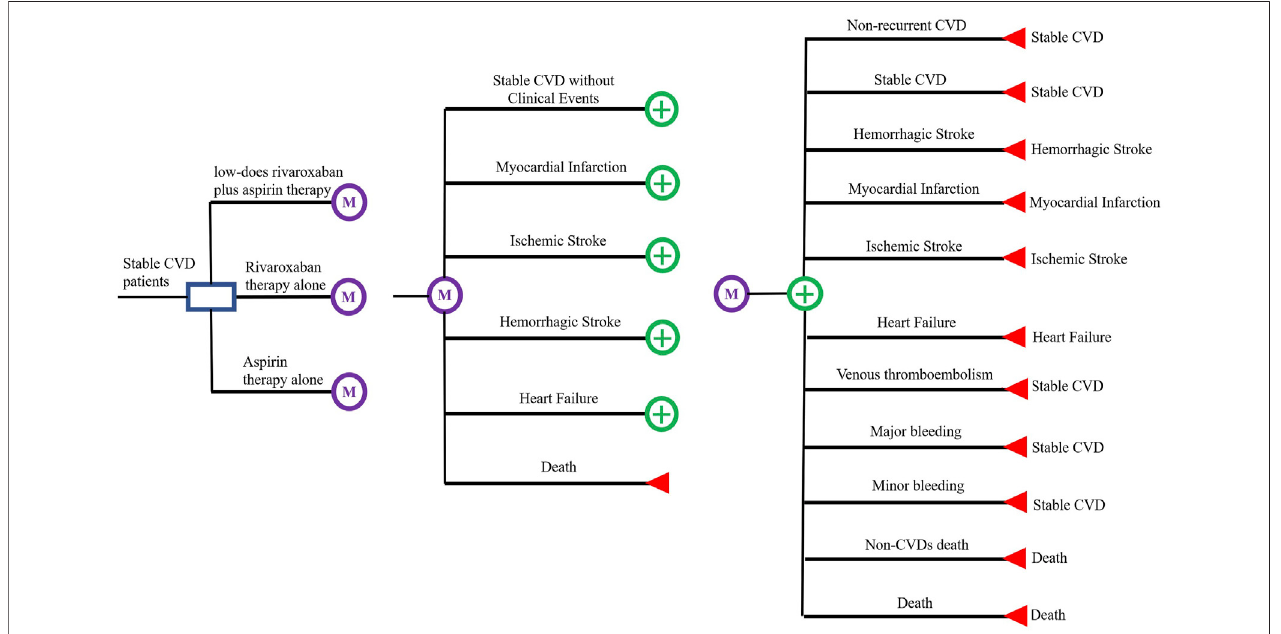
FIGURE 1 | Schematic representation of the Markov